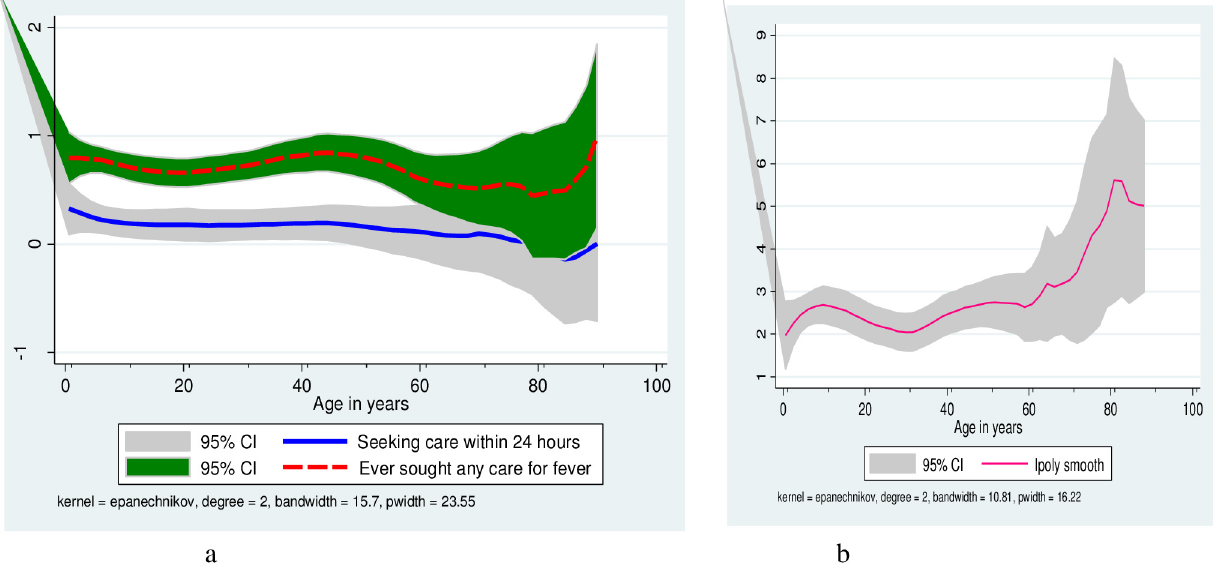
Fig 4. Local polynomial regression smooth for probability of seeking any care, and prompt among people with fever, Jimma, Jan 2014. “ Fig 4a ” shows the probability of seeking any care for fever (red-broken line) and how prompt it is (i.e. within 24 hours after onset of fever) (blue-solid line). Accordingly, in both cases the probability of seeking any care for fever and seeking care within 24 hours are higher during early ages. “ Fig 4b ” indicates time to seek first care (in days) by age and it is also more prompt for childhood illnesses.